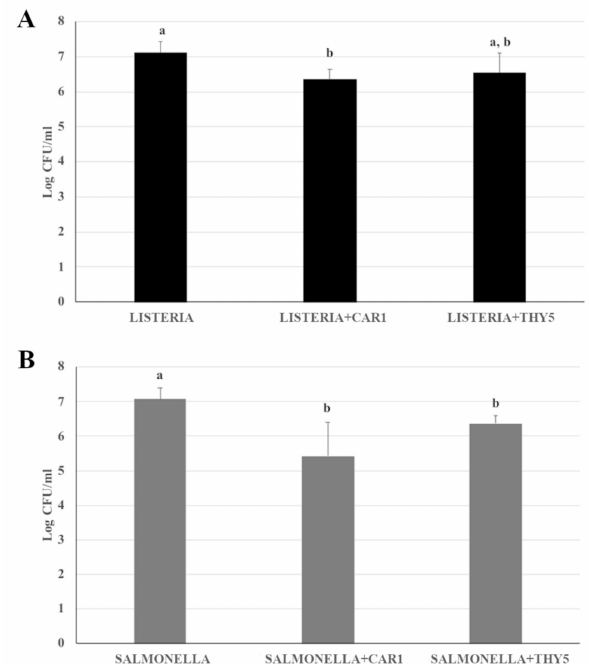
Figure 5. Adhesion reduction test for ( A ) L. monocytogenes OH and ( B ) S . Typhimurium LT2 in the presence of 0.02% CAR1 or THY5 in Caco-2 cells. Bacterial cell viability is expressed as the geometric mean of CFU/mL ± SD of the two independent experiments, carried out in triplicate. Means without a common letter significantly differ, p <